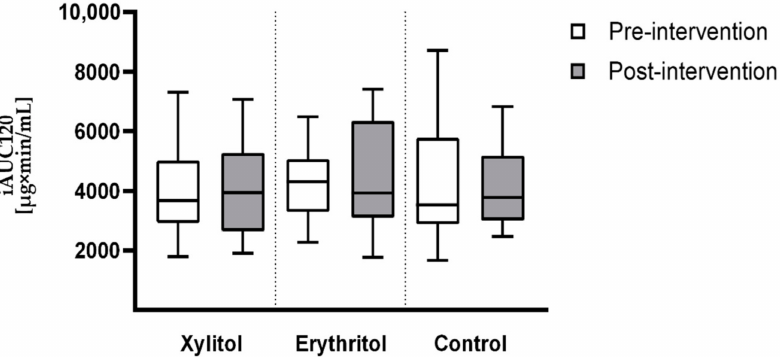
Figure 2. Boxplots of 3-OMG iAUC120 for each group before and after intervention. Data are displayed as median and inter-quartile